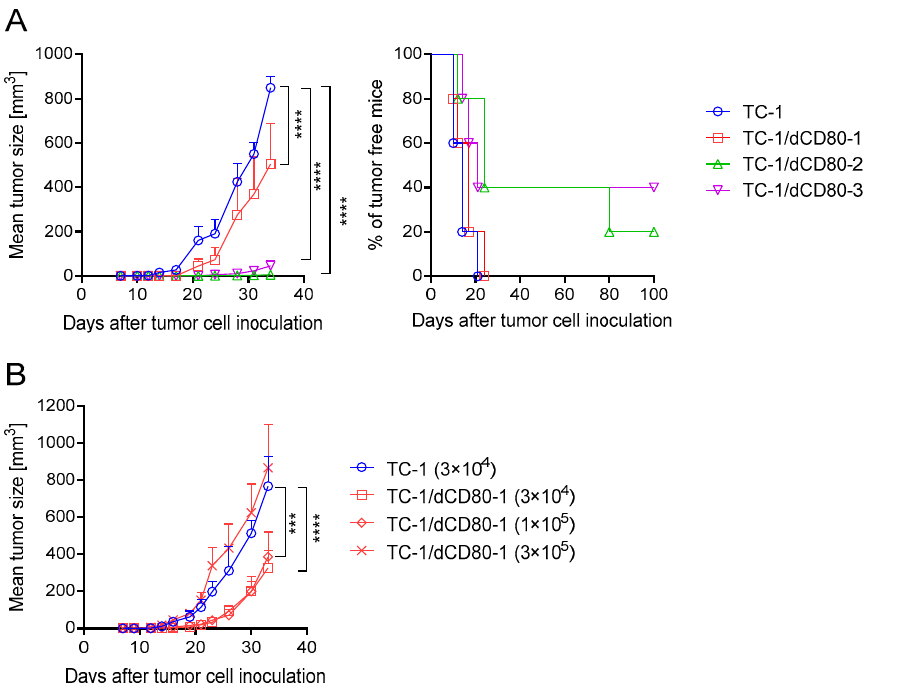
Figure 2. TC-1/dCD80 immunogenicity in comparison with TC-1 cell line. C57BL/6 mice ( n = 5) were subcutaneously (s.c.) injected with 3 × 10 4 cells of three TC-1/dCD80 clones ( A ) or three different doses of the TC-1/dCD80-1 clone ( B ). In total, 3 × 10 4 TC-1 cells were inoculated for comparison. Tumor growth and tumor formation were evaluated. Statistical analysis indicates a comparison with TC-1 cells. Bars indicate ± standard error of mean (SEM); *** p < 0.001, **** p < 0.0001.